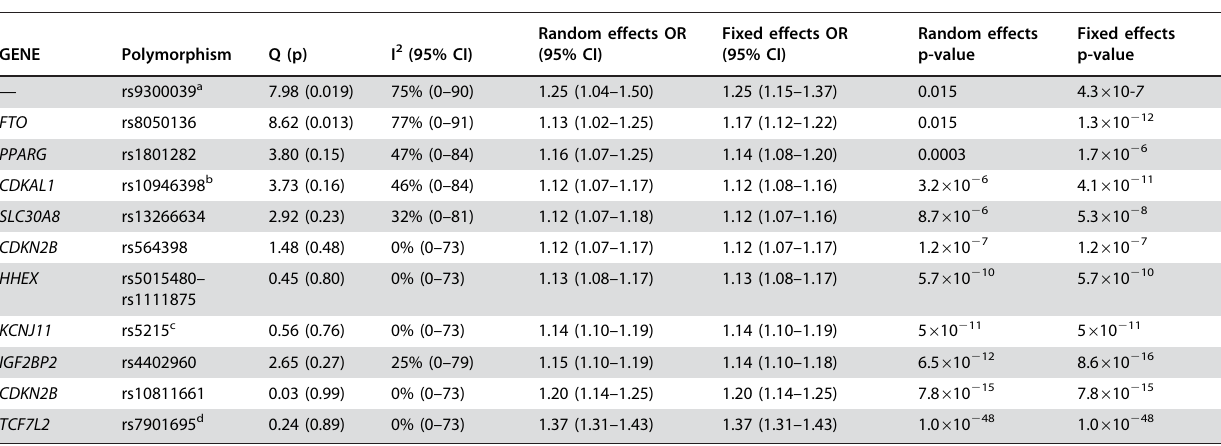
Table 1. Between-study heterogeneity and random versus fixed effects calculations for polymorphisms that were